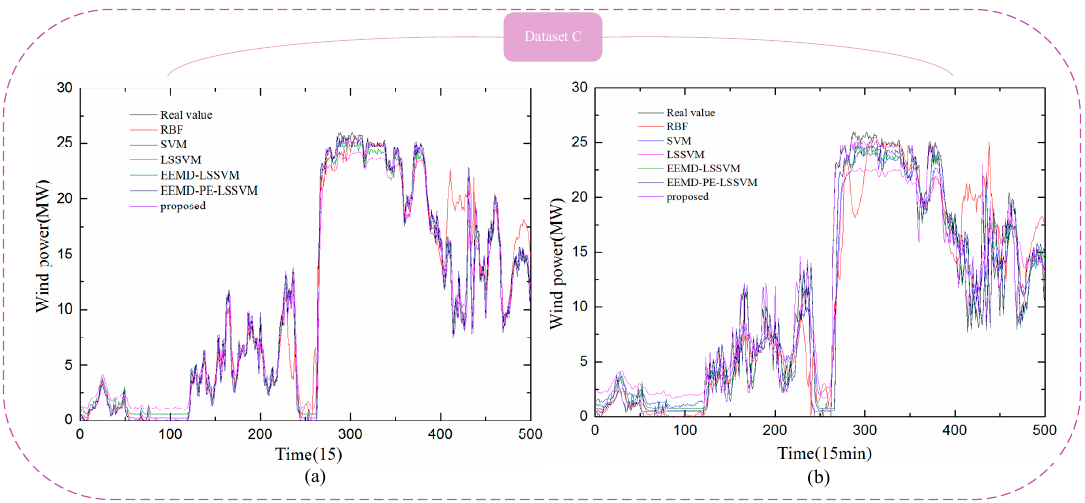
4-step-ahead result.